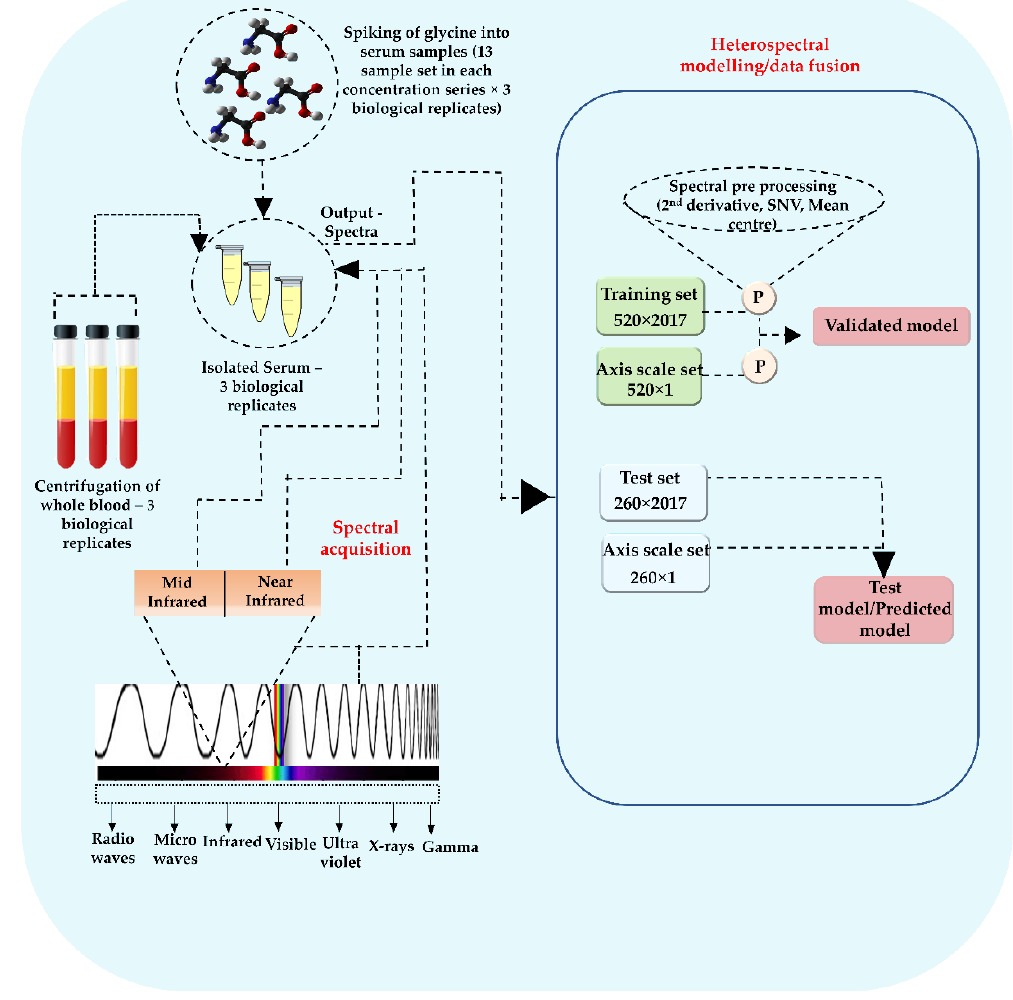
Figure 1. Conceptual representation of experiment and associated chemometrics.